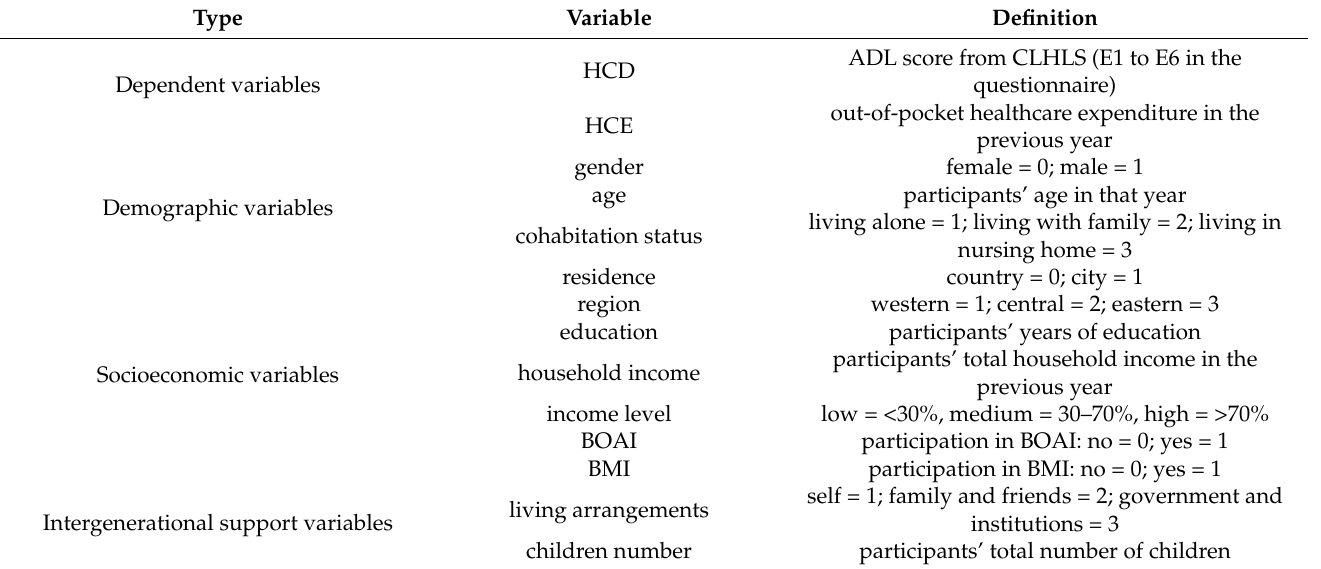
Table 1. Assignment of